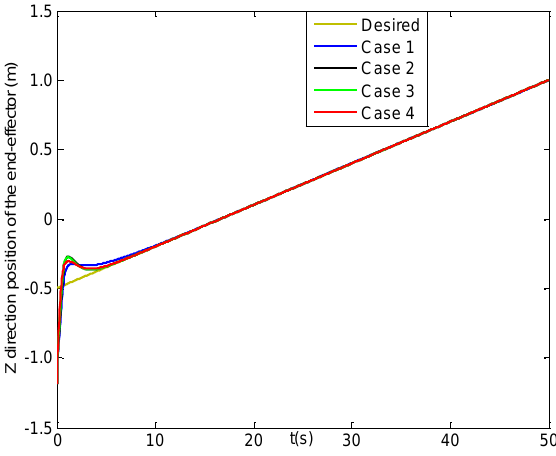
Figure 8. Z direction positions of the end − effector (four cases).